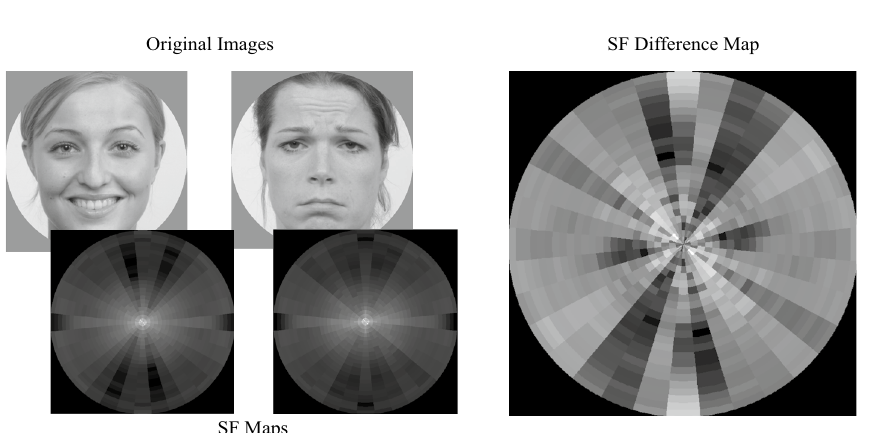
Figure 2. Visualisation of the HOG feature extraction showing an example of two images used in a trial, their respective HOG features and the HOG feature differences map using the highest resolution (10 × 10 cell size). All HOG maps use the same x and y axes as the original images, meaning position in the HOG map is directly coupled with position in an image. The HOG maps show 20 × 20 grids where each position in the grids represents an area of 10 × 10 pixels. For each 10 × 10 pixel area in an image, the weights for 9 differently oriented gradients are calculated. The 9 weights are visualized by white bars where the length reflects the weights. The 9 bars are then superimposed on the 10 × 10 pixel area there are based on. The HOG feature differences map was calculated by subtracting these HOG features weights of the image presented on the right, from those of the image on the left. Note that the feature difference map is scaled such that dark regions indicate negative values and light regions indicate positive